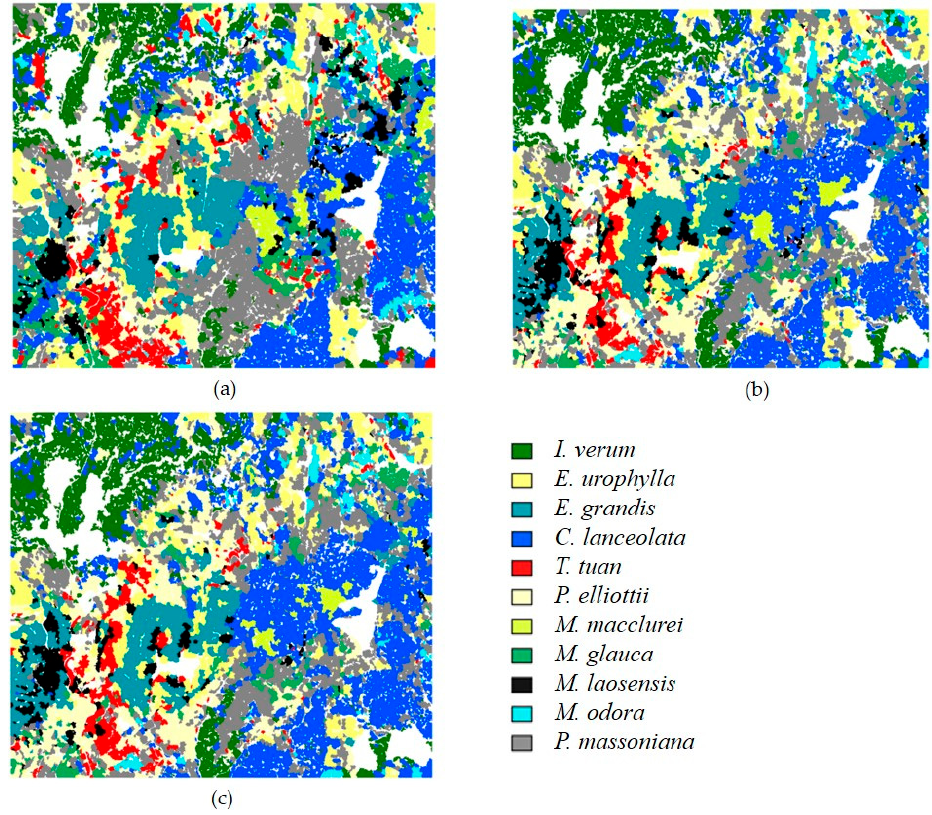
Figure 15. The classification results of three methods. ( a ) The FSP result based on KL. ( b ) The results using aerial and time-series image based on KL. ( c ) The results of using aerial image alone based on KL. Table 4. The average of overall accuracy for ten performances using the KL, CAM, and RSSDA classifiers. Fusion of Aerial Image and Time- Fusion of Aerial Image, Time-Series Images, and Li- Aerial Alone Series Images DAR Data